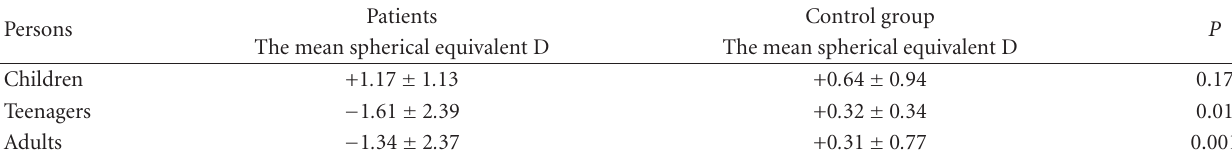
Table 2: The mean spherical equivalent in patients with Graves’ disease.